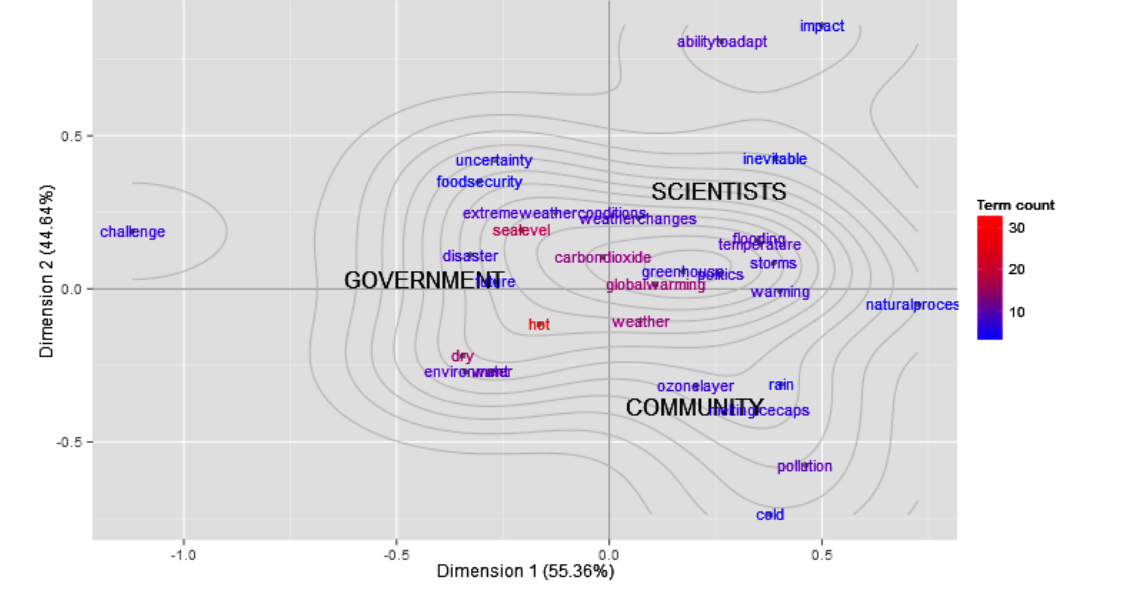
Fig. 3. Correspondence analysis biplot for the 30 most frequently occurring word categories associated with climate change within each of three respondent groups: scientists/academics/researchers, government employees, and community